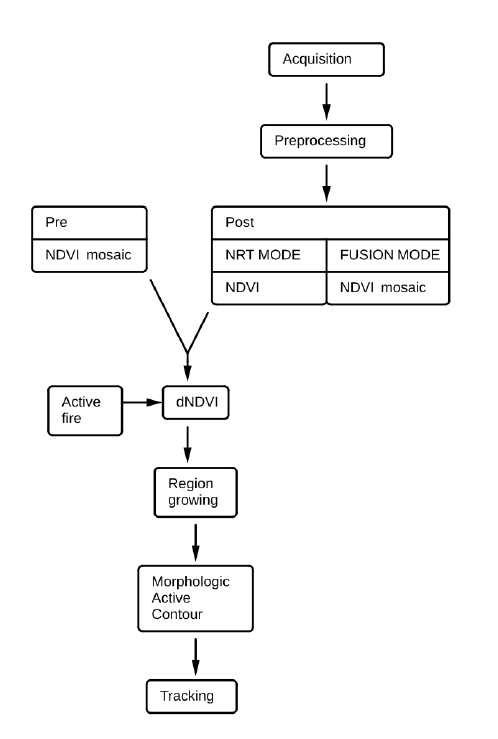
Figure 1. Schematic workflow for the burnt area derivation, from Nolde et al.